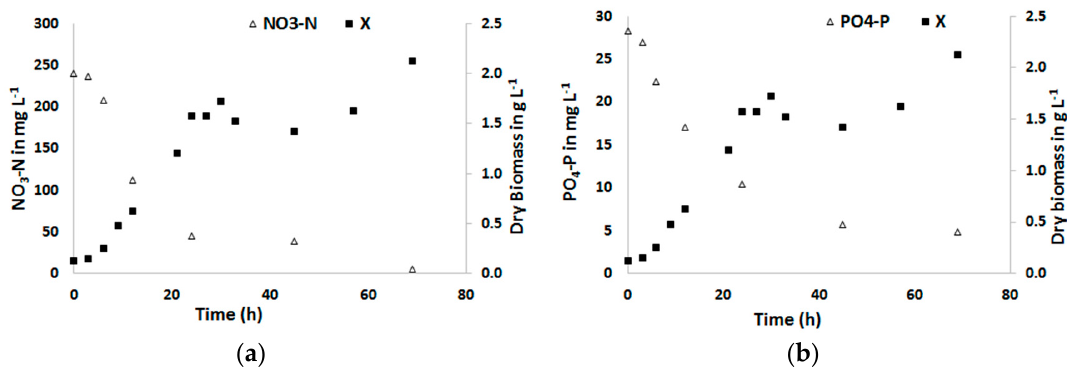
Figure 2. Dry biomass concentration of Chlorella sorokiniana (X) in g L − 1 as grown in the defined medium and the concentrations of ( a ) NO 3 − N and ( b ) PO 4 − P in the e ffl uent in mg L − 1 .